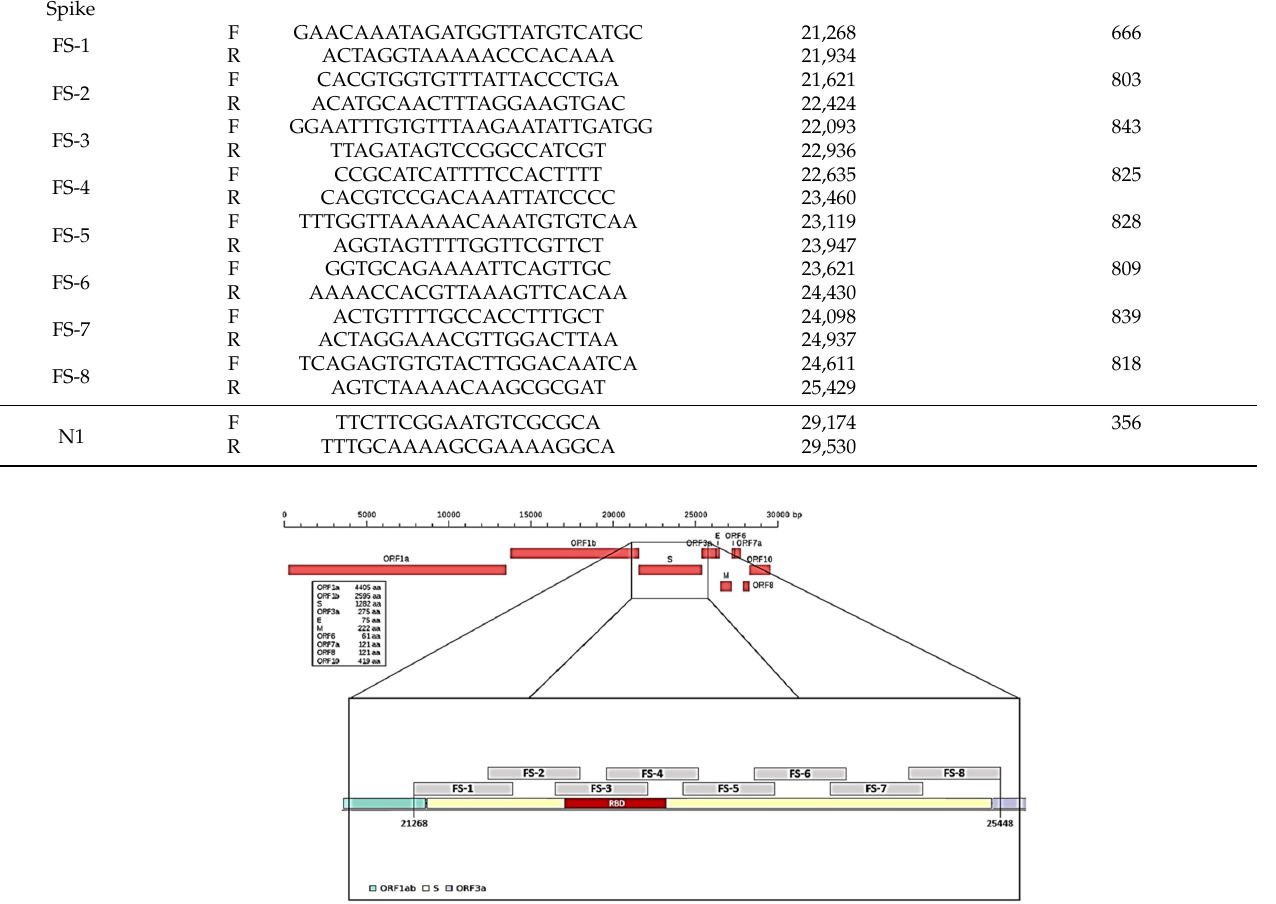
Figure 1. Splitting of the spike gene into eight regions (fragment spike, FS). Subsequently, for all 80 RNA samples, selective reverse transcription with the F3 pri- mer was performed and the obtained selective cDNA was used to amplify a region of 1312 bp that we named the “Hot Spot Mutation Fragment” as it contains all mutations that allowed us to characterize the different clones (Figure 2).